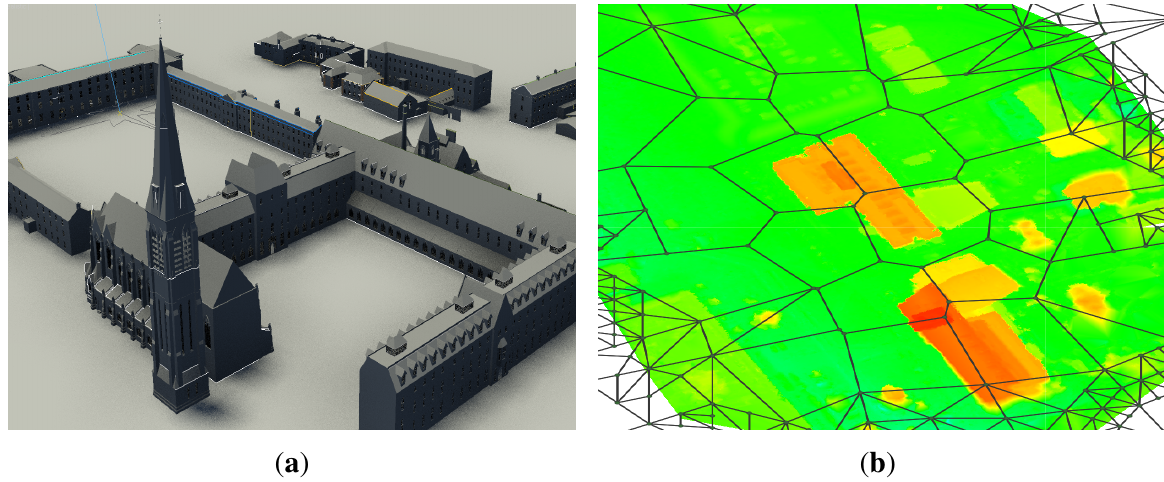
Figure 3. Modelling obstructions ( a ) a 3D vector model of Maynooth University South Campus created during the 3D Campus project ( b ) a 2.5D raster DSM of buildings on Maynooth University North Campus created using photogrammetric methods from imagery captured by a Falcon 8